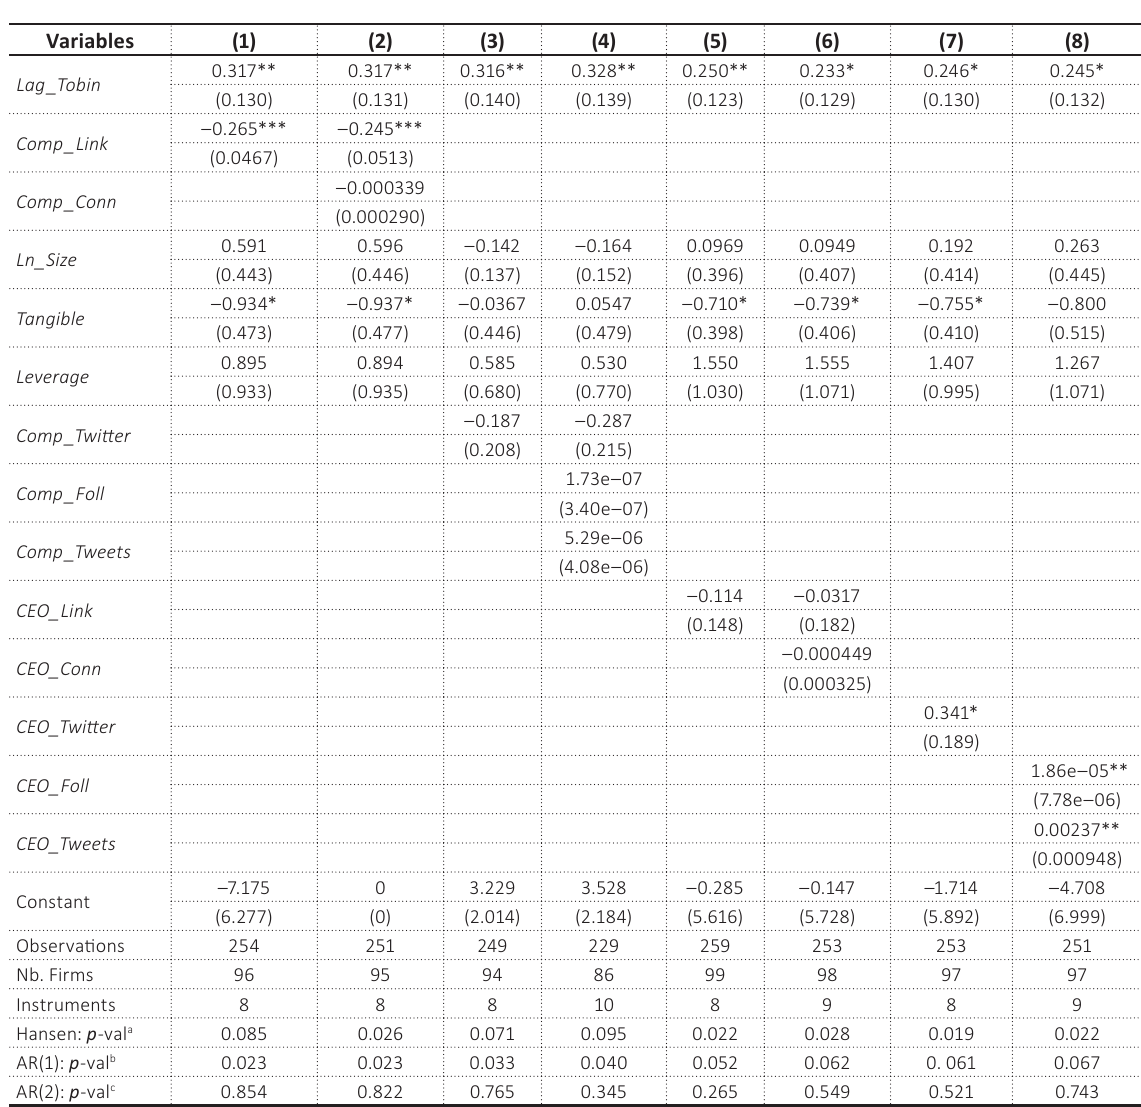
Table 7. Estimation results using Tobin’s Q performance